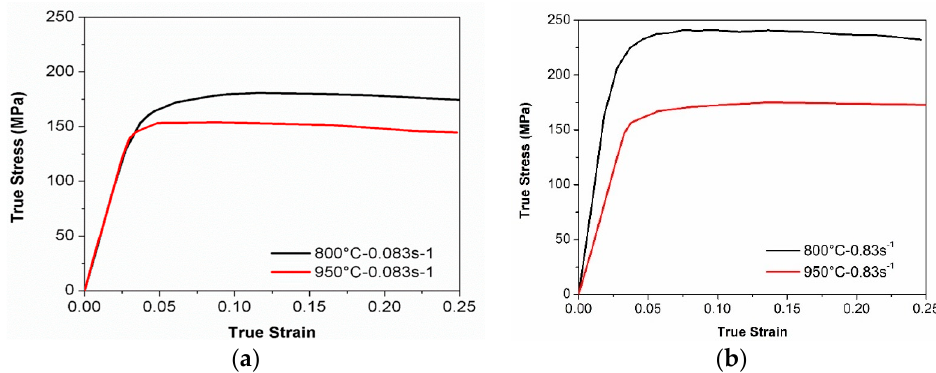
Figure 8. Hot flow curves of medium-Mn steel with 0.1% Nb analyzed at two temperatures (800 and 950 °C); and constant strain rates of ( a ) 0.083 and ( b ) 0.83 s − 1 .